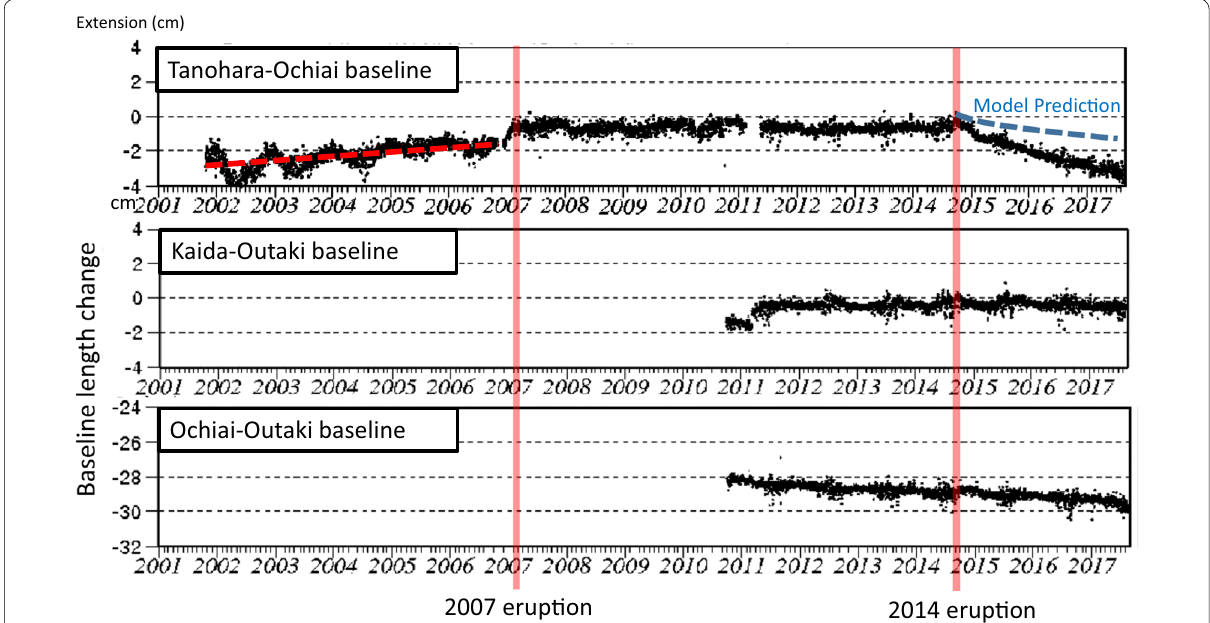
Fig. 7 Time series of the GNSS baselines whose locations are shown in Fig. 1. The original plots were made by the Japan Meteorological Agency. Blue dashed line is the baseline length change predicted by the shallow deflation source model, whereas the red dashed line on the left indicates the expansion trend during 2002–2007. A rapid extensional change of 2 cm at the time of the 2007 eruption was interpreted as inflation of a source at 3 km depth by Takagi and Onizawa